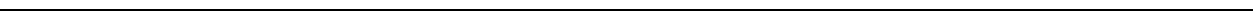
Fig. 1 Normal cell composition but neuronal enlargement of Tsc1-cko mouse retina. a Distribution of cells underwent Cre-mediated deletion of Tsc1 gene in E14.5 Tsc1-cko;R26 + /lacZ mouse retina was visualized indirectly by immunodetection of ß-galactosidase (ß-gal), which is expressed from a lacZ gene at Cre- recombined R26R locus. Activities of mTORC1 and mTORC2 in the retinas were also measured by immunodetection of pS6 and pAkt(S473), respectively. Scale bars, 100 μ m. b Relative levels of mTOR pathway components in the mouse retinas were examined by western blotting (WB) with antibodies against corresponding proteins. SM size marker. c Hematoxylin and eosin (H&E) staining images of P14 Tsc1-het and Tsc1-cko littermate mouse retinal sections. Sizes of blue and green bars in two bottom images are same. Scale bars, 100 μ m. d P14 littermate mouse eye sections were stained with antibodies